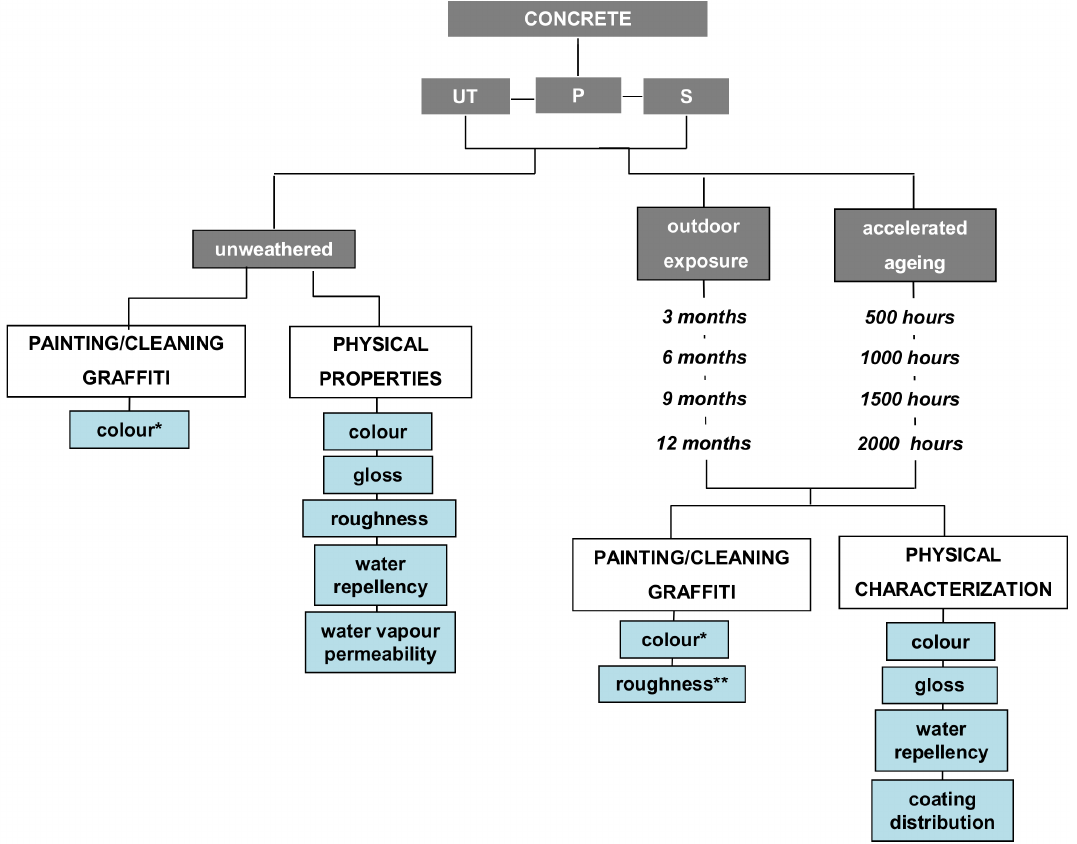
Figure 1. Flow chart of the experimental procedure on untreated concrete (UT) and treated with the permanent (P) and sacrificial (S) anti-graffiti coatings. * For the untreated samples, there was only one painting-cleaning cycle before weathering; for the ones coated with the sacrificial coating, there was one cycle before weathering and another cycle at the end of both ageing trials; and for the samples coated with the permanent product, there were four cleaning cycles before weathering and four cycles during the ageing trials. ** At the end of both ageing trials on the coated samples.